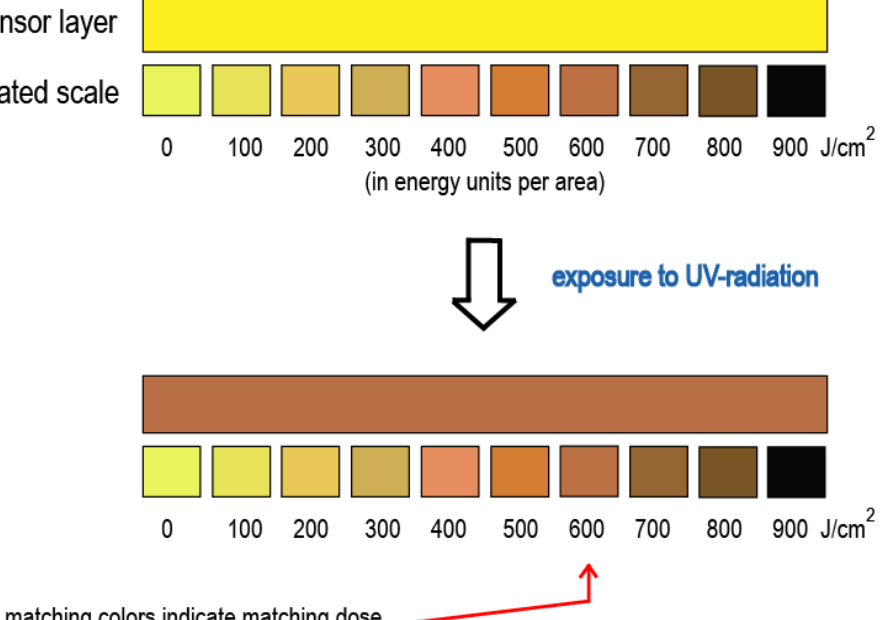
Figure 20. Practicality of color change upon exposure of Ag(I) cyanoximates to short-wavelength UV-radiation: potential for the battery-less colorimetric area detector for high-energy